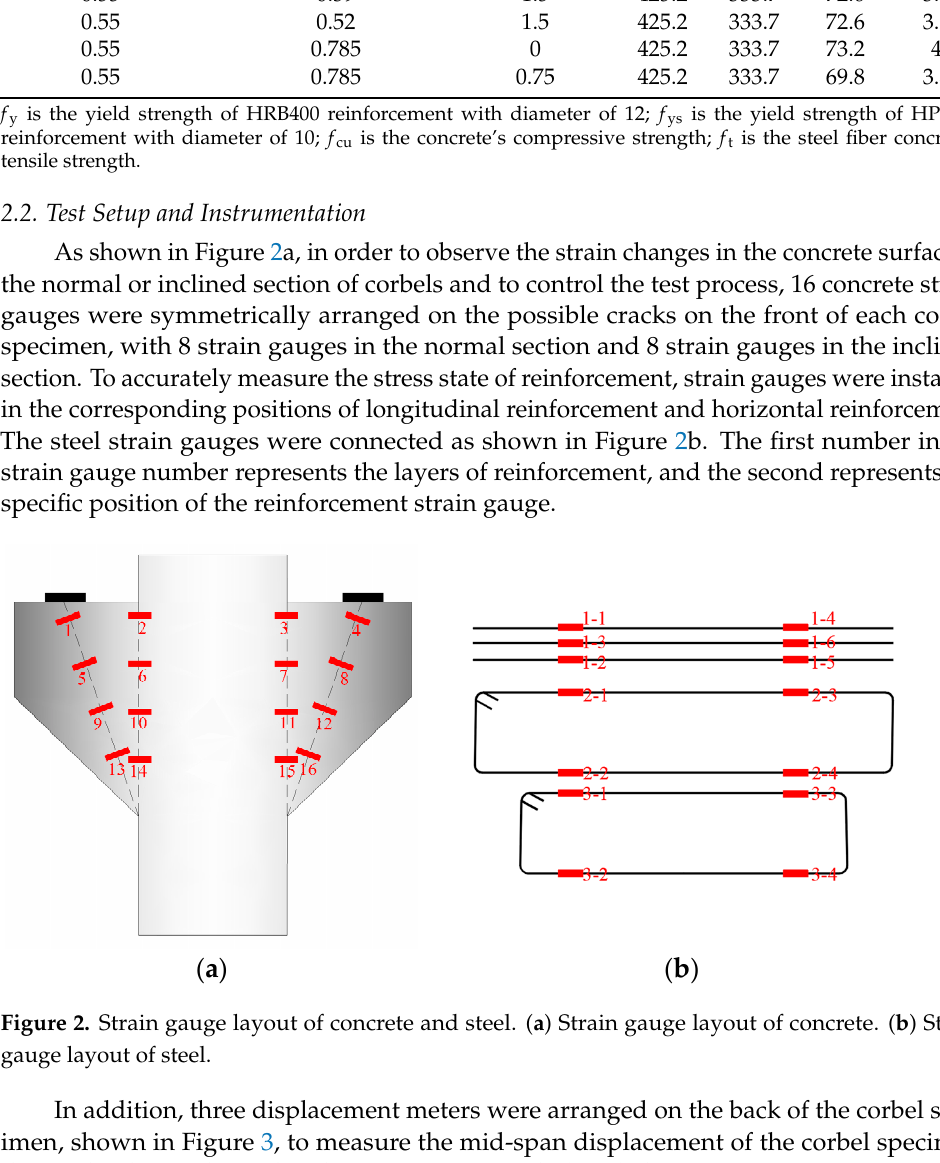
Table 1. Parameters of corbel specimens.